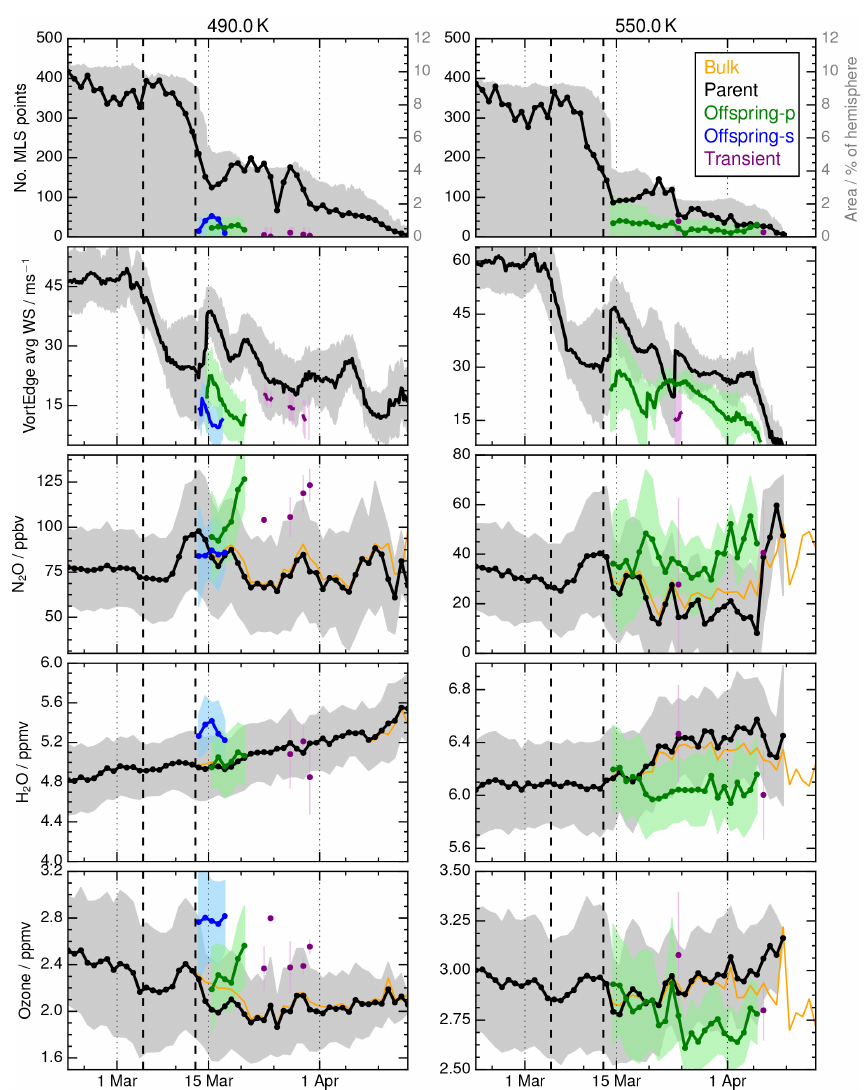
Figure 14. Vortex characteristics and MLS trace gas averages in individual vortex regions in the lower stratosphere. Top panels show the area of each vortex (shading) along with the number of MLS measurement points inside each vortex on each day (lines/symbols). The second row shows wind speeds from MERRA-2 averaged around the edge of each individual vortex. Succeeding rows show averages of MLS N 2 O (third row), H 2 O (fourth row), and ozone (fifth row) in each vortex region. In all rows except the first, the shading indicates ± 1 standard deviation envelopes. In the MLS averages, the orange lines indicate the “bulk” values (that is, within the vortex edge contour even if the area does not exceed the 84 ◦ EqL cutoff; see Sect. 2.4). In all other cases, the lines are colored/labeled to be consistent with the parcels/regions highlighted in Figs. 12 and 13. The offspring vortices are designated “-p” for the more persistent ones and “-s” for the shorter-lived ones, as per the discussion of Figs. 10 through 13; offspring vortices that persisted for about a day or less are labeled